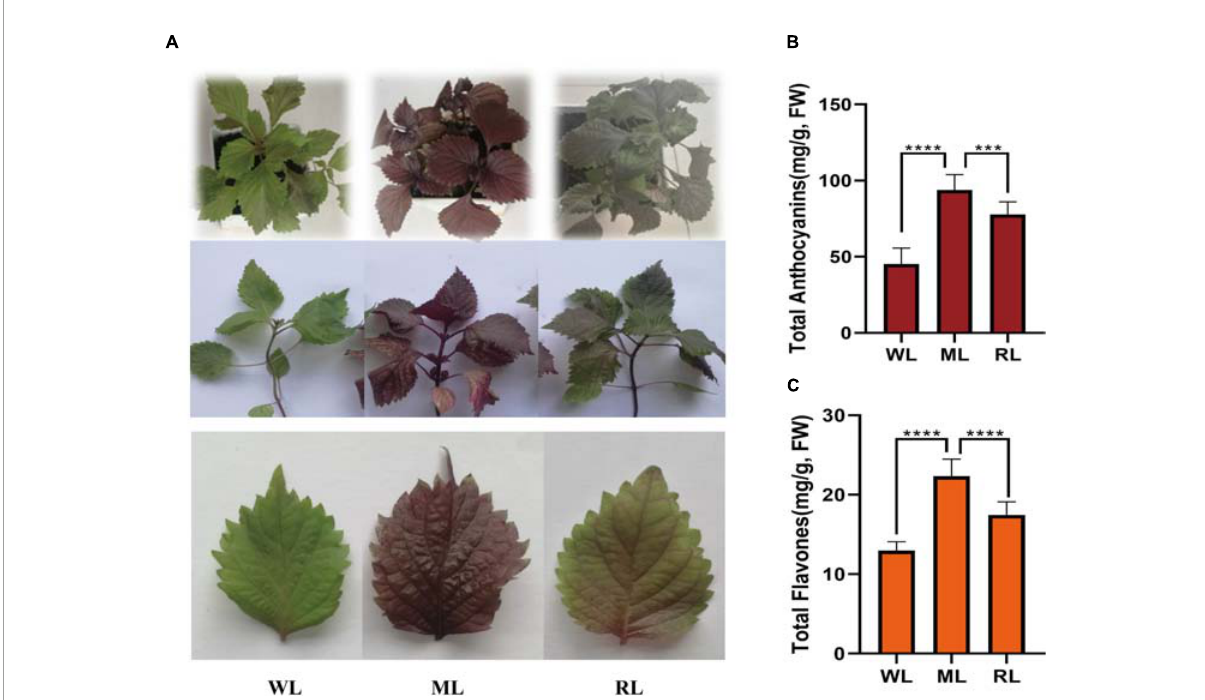
FIGURE1 Leaf color, anthocyanin, and flavone contents of perilla under different light intensity treatments. (A) Phenotypes of perilla. (B) Total anthocyanin contents of perilla leaves. (C) Total flavone contents of perilla leaves under WL, weak light; ML, moderate light for 6 days; RL, recovered weak light for 6 days. **** Indicates P value <